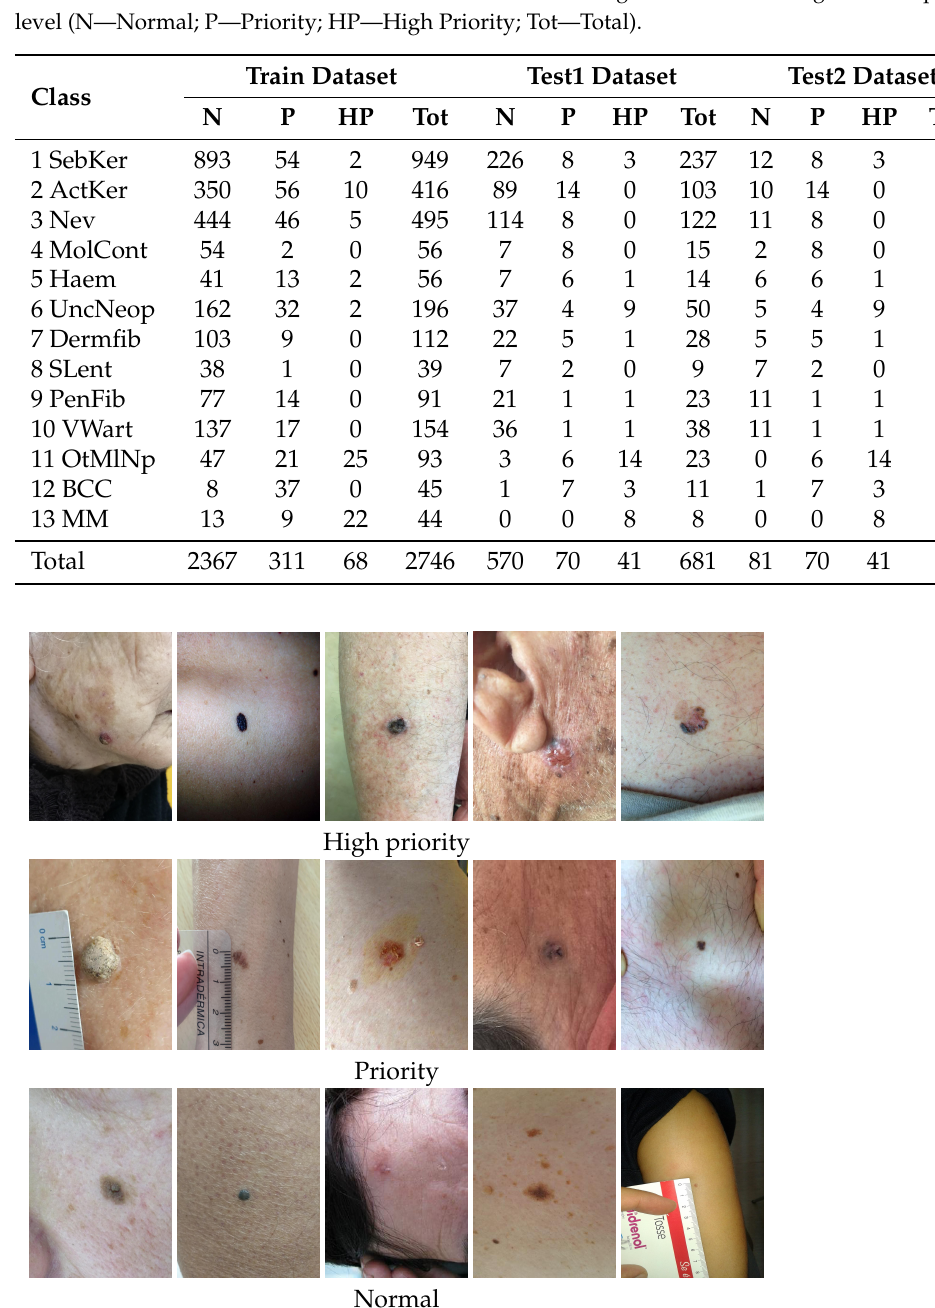
Table 1. DermAI train and test dataset distribution considering the differential diagnosis and priority